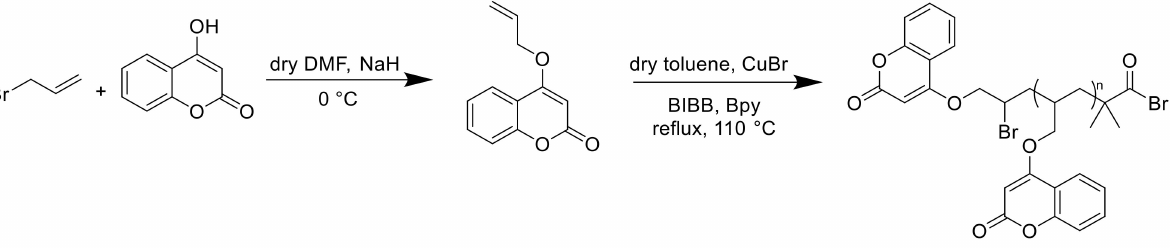
Figure 28. Synthesis of 4-allyloxycoumarin and its polymerization via atom transfer radical polymerization (ATRP).